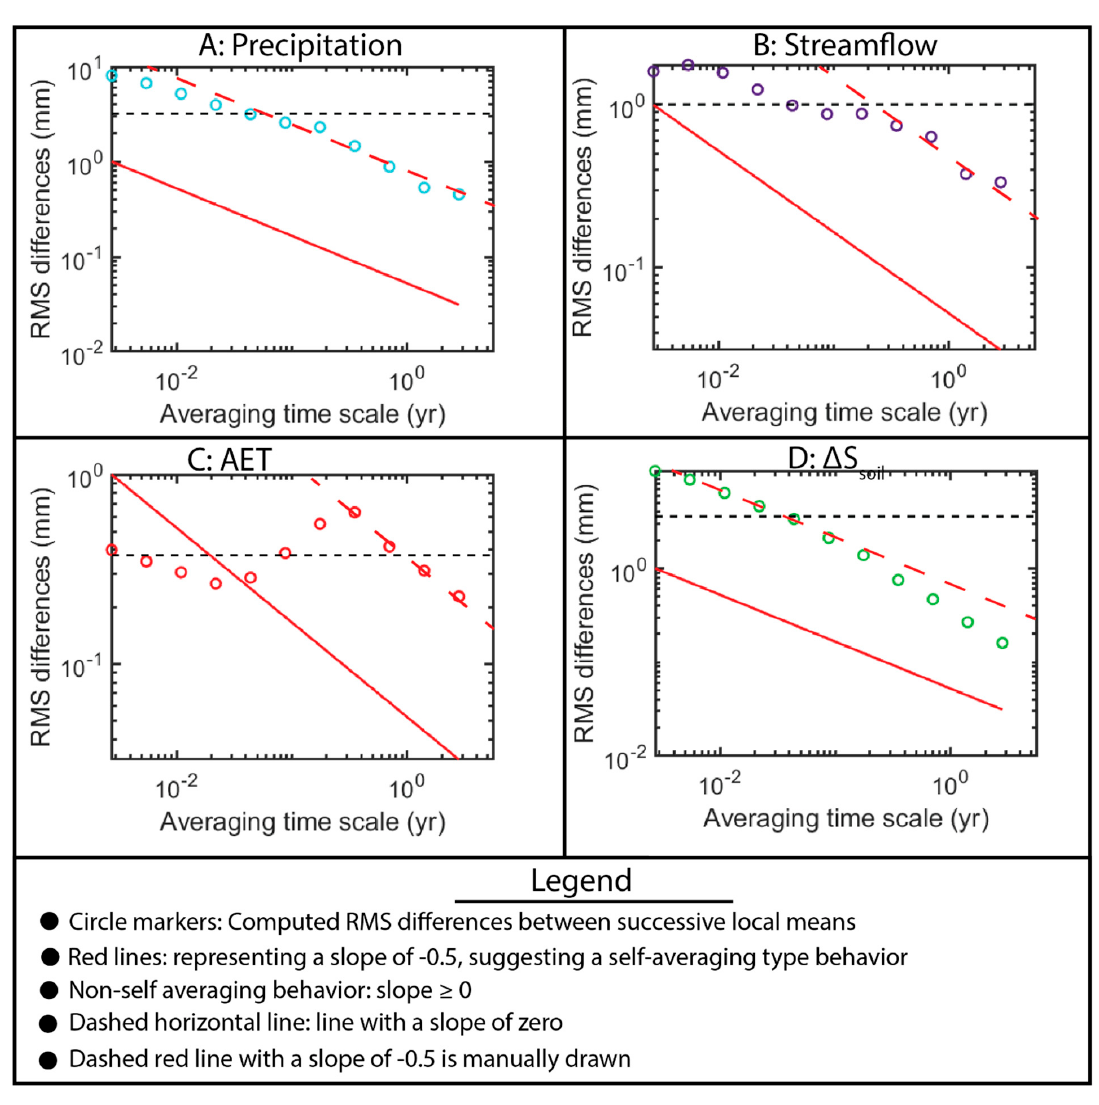
Figure 7. Root mean square (RMS) differences between successive local averages of precipitation ( A ), streamflow ( B ), actual evapotranspiration ( C) , and the change in soil water storage ( D ) as a function of the averaging time scale.